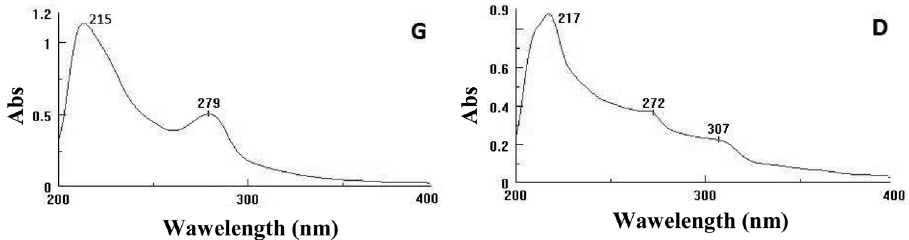
Figure 5. UV-VIS-NIR spectra of the ethanol extracts of M. graniger graniger ( G ) and M. graniger dragani ( D ) (Abs = Absorbance units).